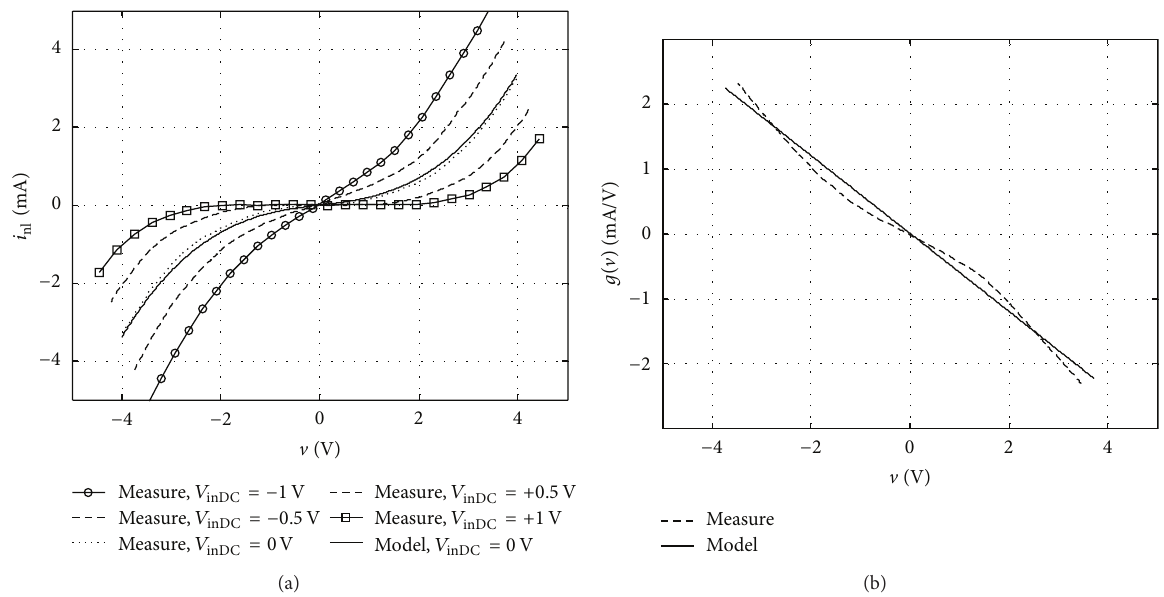
= 0.13 mA / V, 𝑏 = 40 uA / V 2 , and 𝑐 = 35 uA / V 3 . in in in